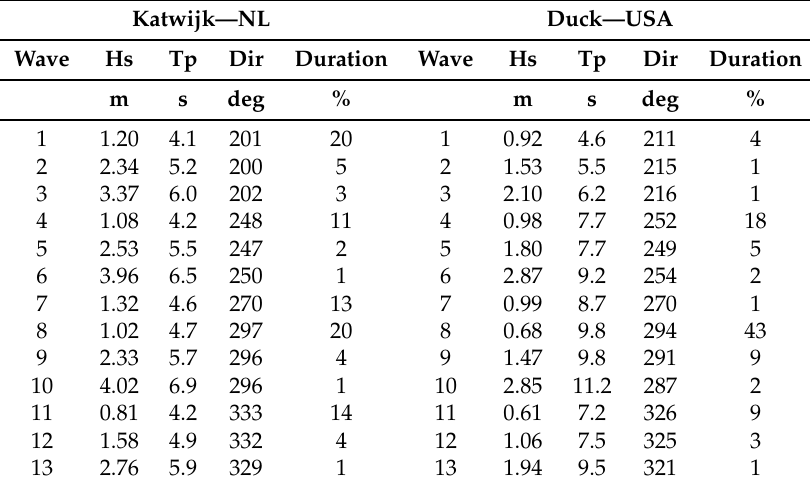
Table 2. Reduced wave climate for Katwijk and Duck to 13 conditions of wave height ( H s ), period ( T p ), direction ( Dir , rotated to the model domain) and normalized duration (%). Wave 7 is the average condition that replaces the offshore-directed and shore-parallel wave